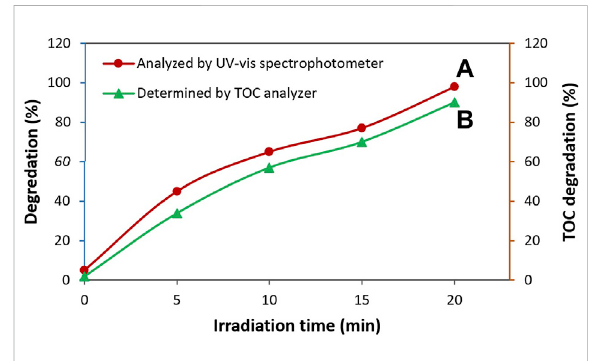
FIGURE 11 Degradation rate of TC using ZnO/NiFe 2 O 4 /Co 3 O 4 obtained from the absorbance measurements (A) and TOC analysis (B) versus the irradiation